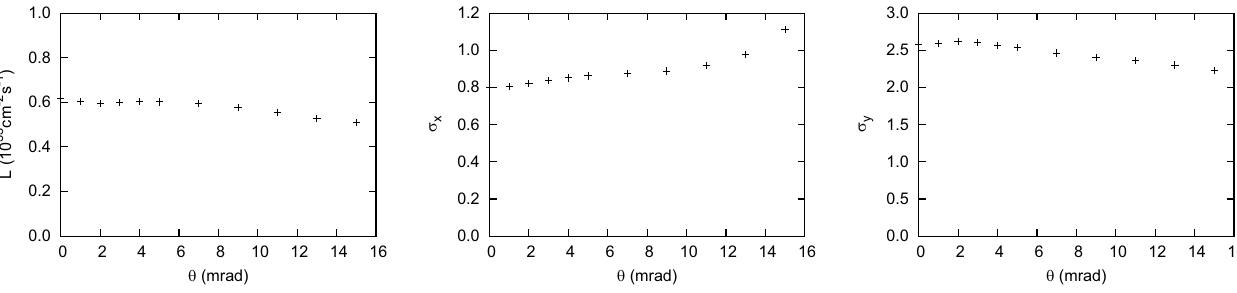
(cid:3) (cid:7) (cid:1) 0 : 53 ; 0 : 58 (cid:3) . The abscissa is half of the horizontal crossing ; 7 x y